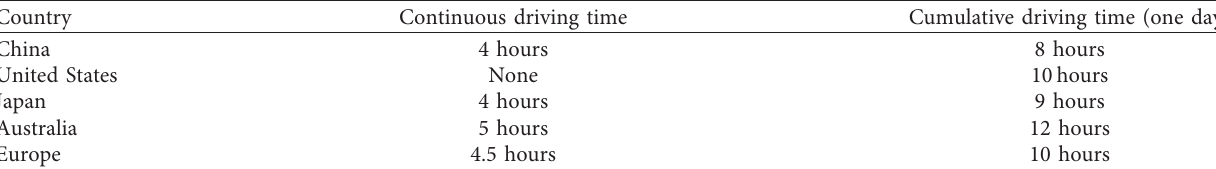
Table 1: The control of driving time by laws of various countries.